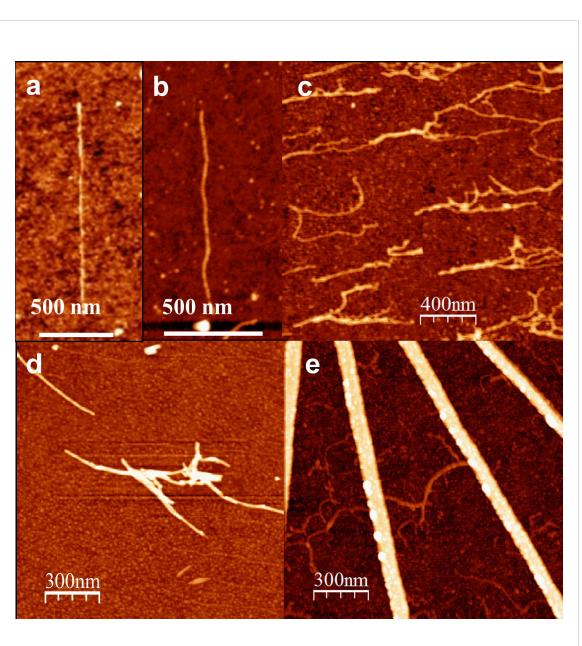
comparable to most values reported in earlier studies [23].